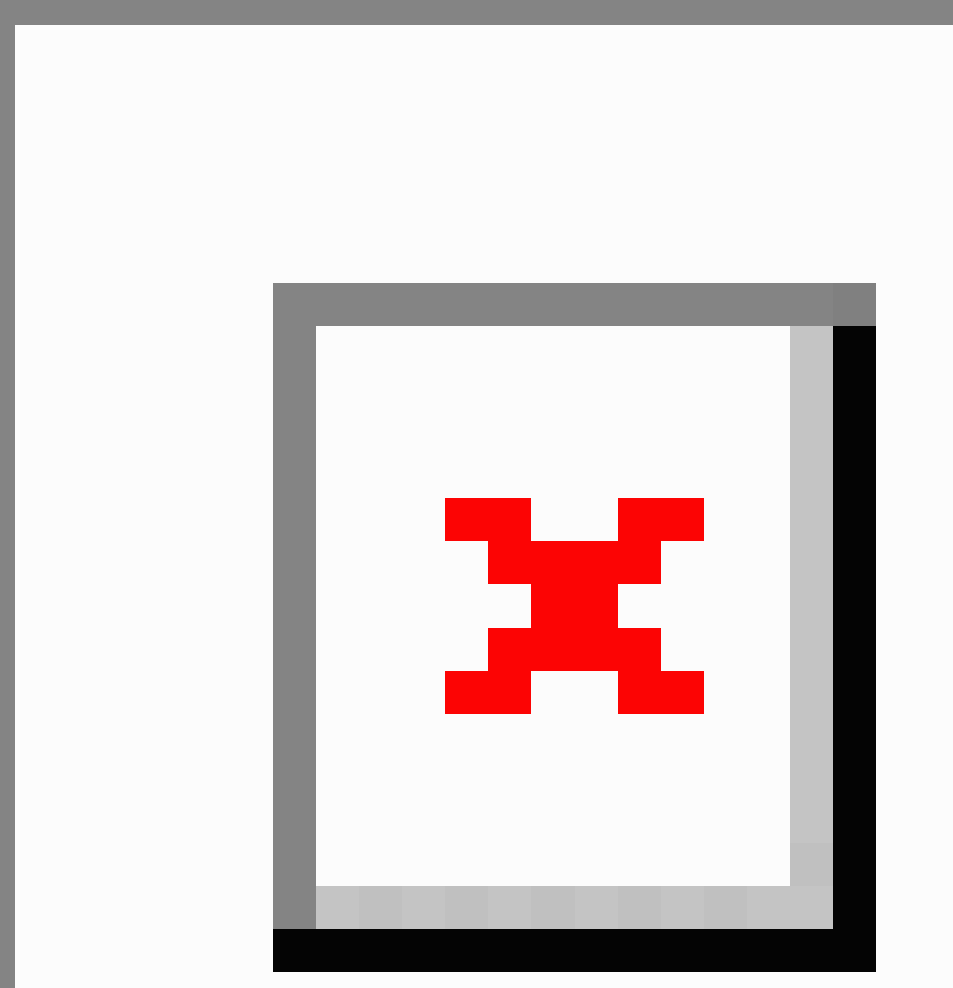
Figure 1. Screenshot of the first webpage with a questionnaire (in Dutch) about care